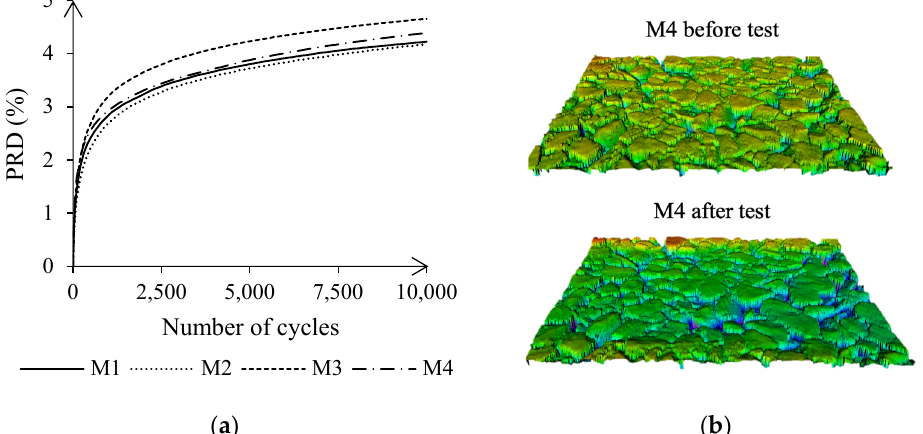
Figure 8. ( a ) Proportional rut depth of asphalt samples after wheel/tracking and ( b ) reconstruction from the scanned lines of a specimen in the mid-center before (MPD of 1.50 mm) and after (MPD of 1.56 mm) wheel tracking.